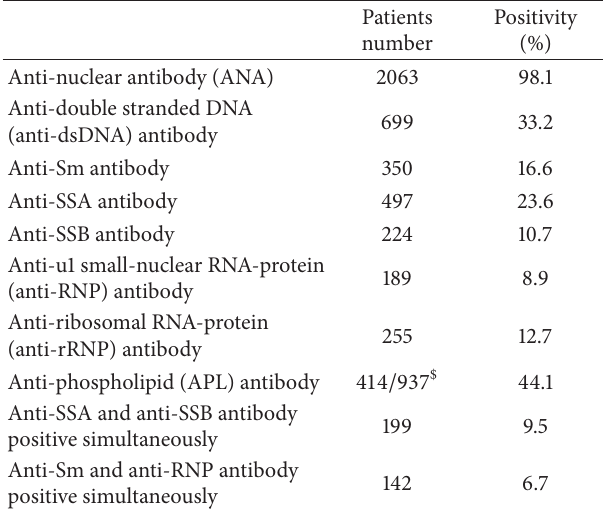
Table 2: The profile of autoantibodies in 2104 SLE patients from CSTAR cohort study.